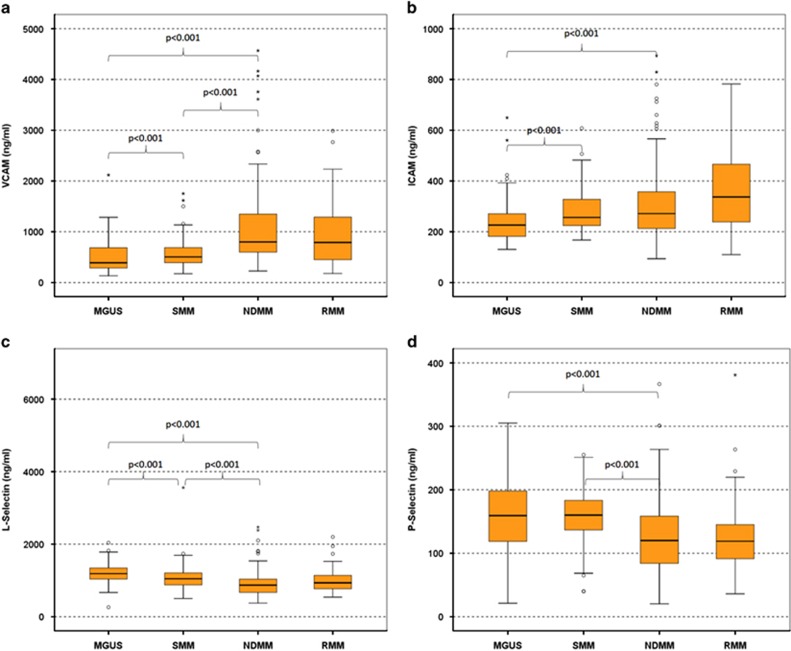
Circulating levels of VCAM (a), ICAM (b), L-selectin (c) and P-selectin (d) in all patients' groups; whisker plots (open circles) refer to outlier values, while 'extreme' values are marked with an asterisk.